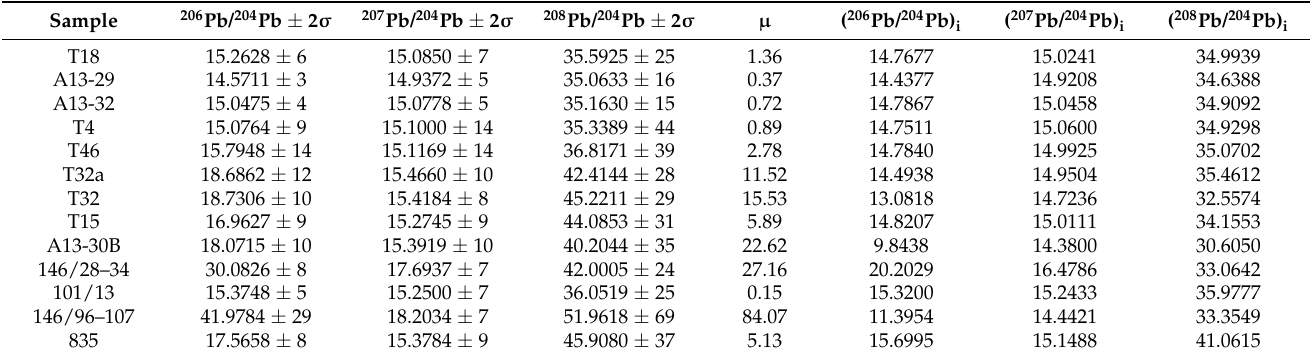
Table 4. Whole rock Pb isotopic data on the rocks of the Tiksheozero